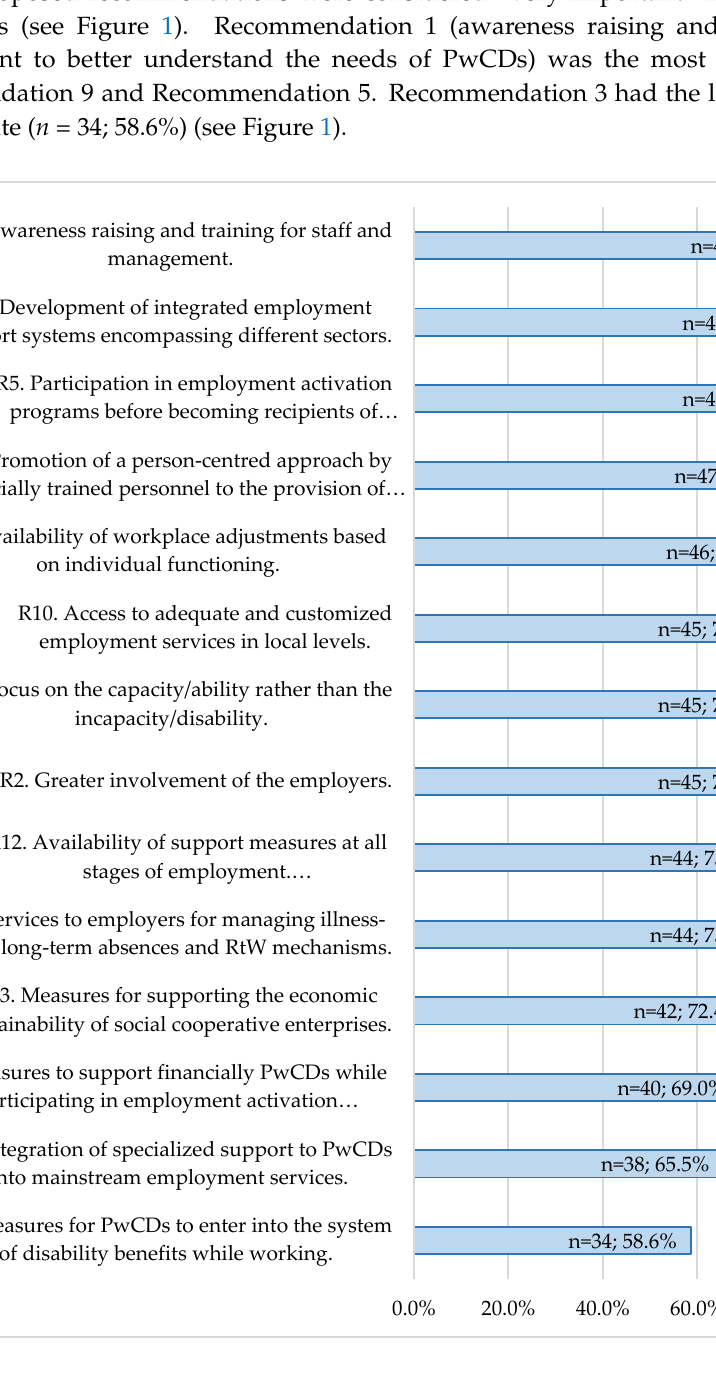
Figure 1. Recommendations’ ranking based on “very important” response rates of the national stakeholders.